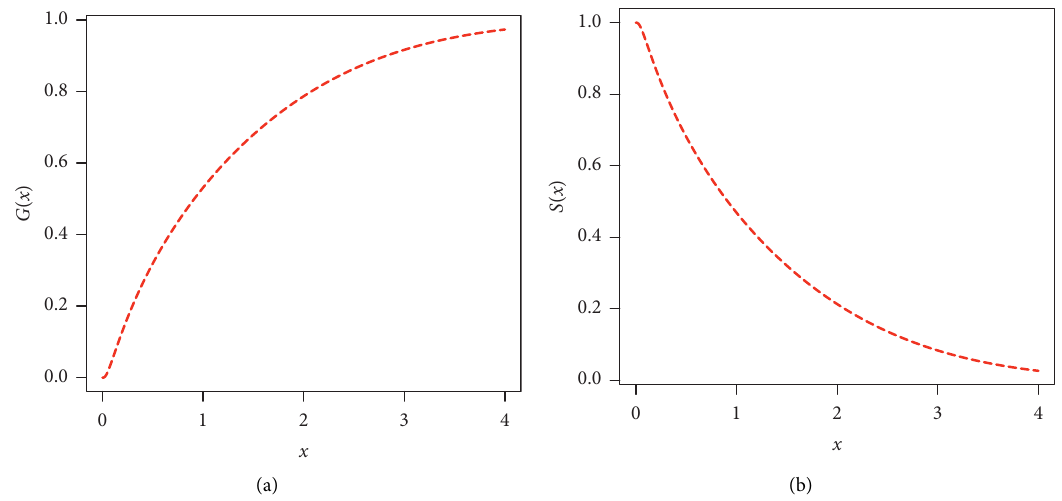
Figure 1: The (a) DF and (b) SF plots of the ASNFEW distribution.